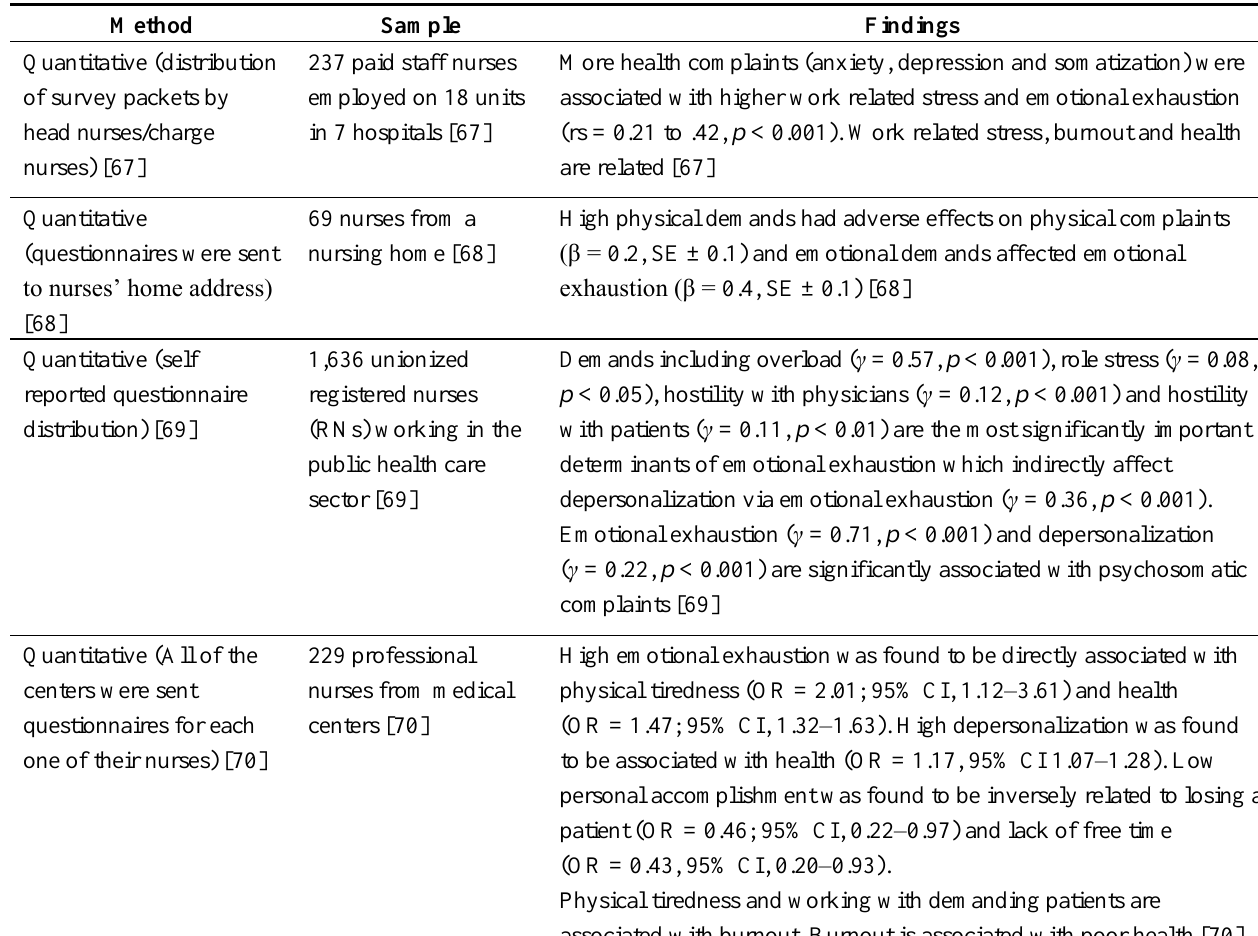
Table 5. Method, sample and findings of identified